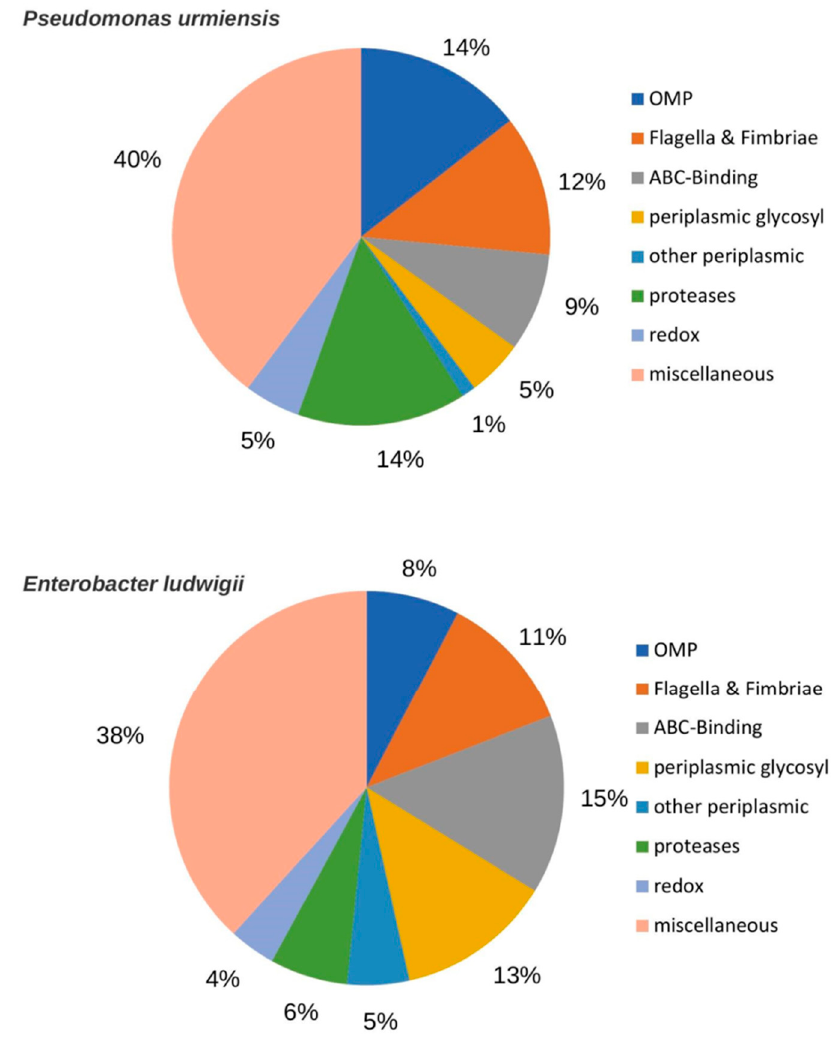
Figure 7. Comparative proteomics profiling of BPMP-PU-28 ( Pseudomonas urmiensis ) and BPMP-EL-40 ( Enterobacter ludwigii ) culture supernatant. Pseudomonas urmiensis and Enterobacter ludwigii were grown in minimal Hoagland medium supplemented with lactate (2%) and buffered (150 mM KH 2 PO 4 /K 2 HPO 4 , pH 6.7). Aliquots of culture supernatant were collected during the stationary phase. Proteins and peptides identified in the growth media and not found in the global proteome of the corresponding bacteria were sorted into 9 classes based on manual annotation (same classes and classification criteria for the two bacterial strains). OMP: outer membrane proteins. Flagella & Fimbriae: proteins belonging to flagella, and long filamentous polymeric protein structures present at the surface of bacterial cells and implicated in adhesion of the bacteria to surfaces, or to other bacteria. ABC substrate: substrate binding proteins of ABC transporters. Periplasmic glycosyl: periplasmic protein implicated in cell wall glycosylation. Other periplasmic: proteins located in the periplasmic space but not involved in glycosylation. Proteases: proteins involved in degradation or maturation of peptides and polypeptides. Redox: proteins involved in oxido-reduction processes. Miscellaneous: proteins with various enzymatic activities and likely to be located neither in the outer membrane, nor in the periplasmic space.